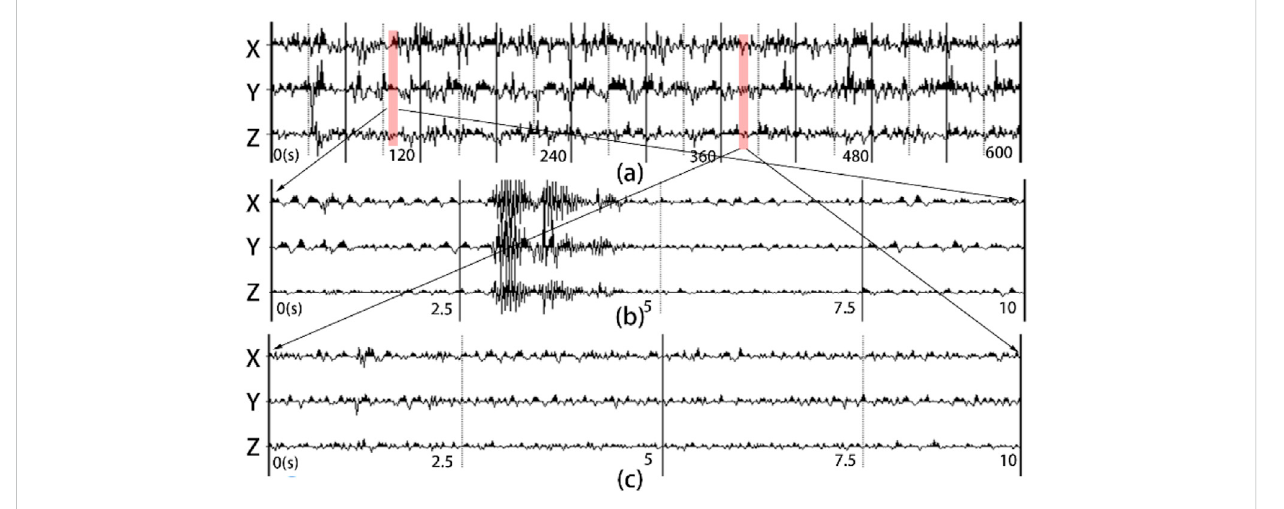
FIGURE 6 A group of three-component seismic records.